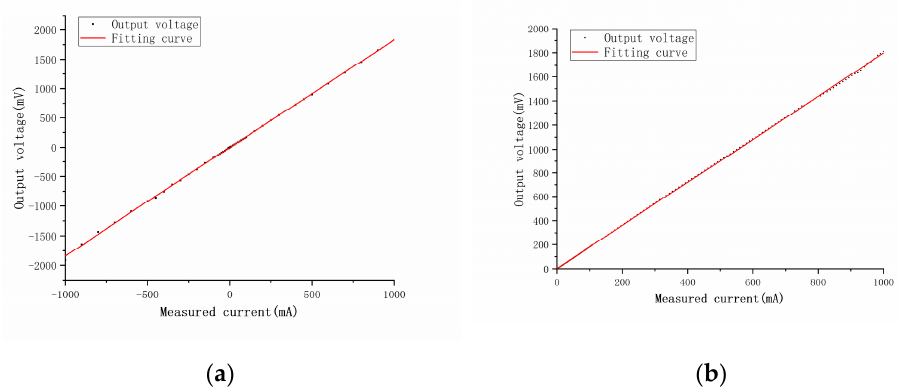
Figure 15. Input and output curves at DC and 50 Hz: ( a ) output curve at DC, and ( b ) output curve at 50 Hz.